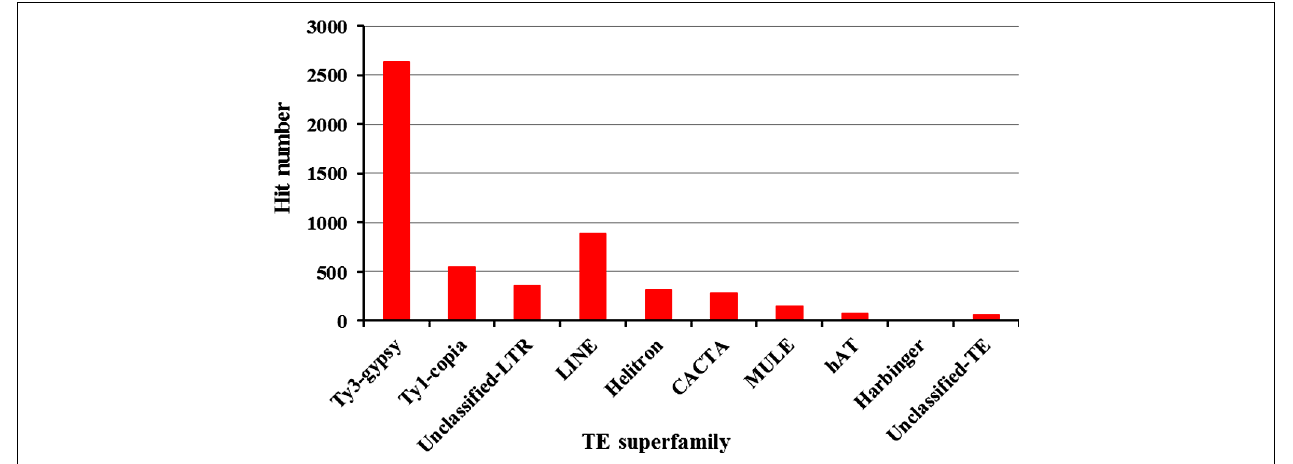
FIGURE 1 | Summary of common bean-derived ESTs that share sequence similarity with different transposons.